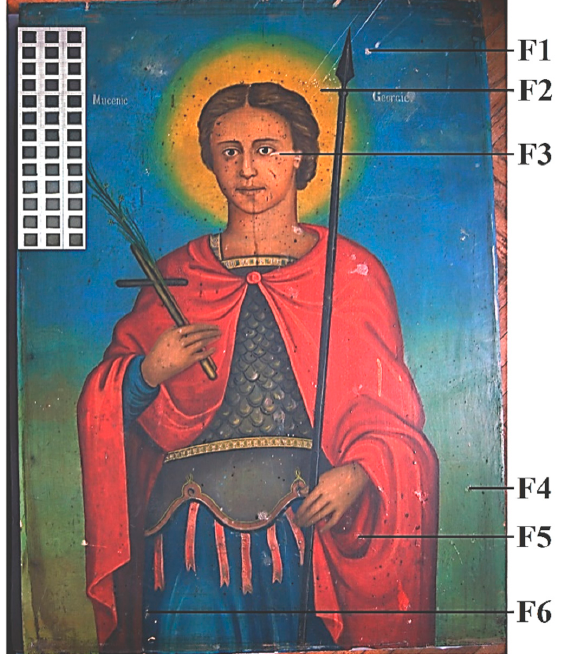
Figure 2. The sampling areas and those used for the washing test in the pictorial layer of the “Saint George” icon: F1—blue background; F2—aureole; F3—carnage; F4—green background; F5—red garment; F6—blue garment.